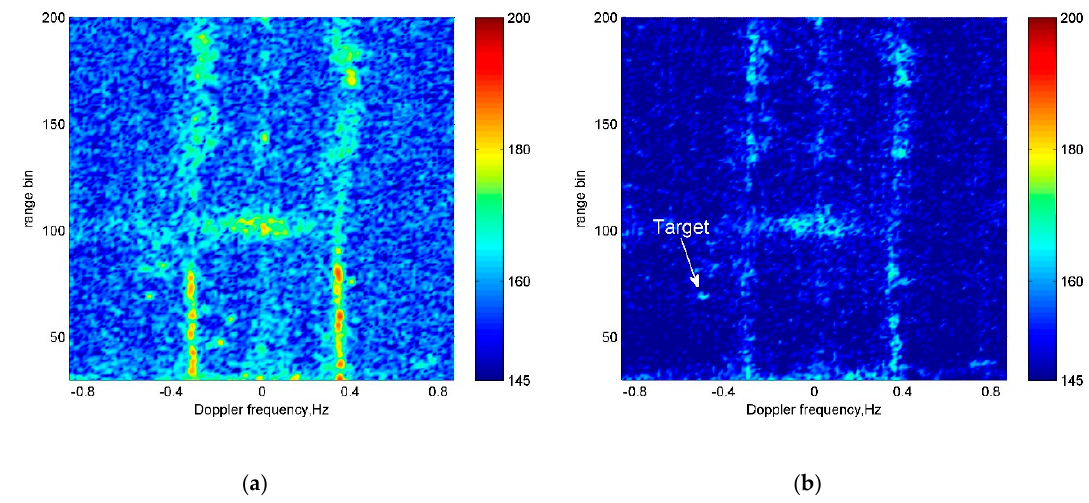
Figure 8. Experimental results using measured data with non-cooperative target. ( a ) Range-Doppler map of DBF method. ( b ) Range-Doppler map of LE-JDL method.